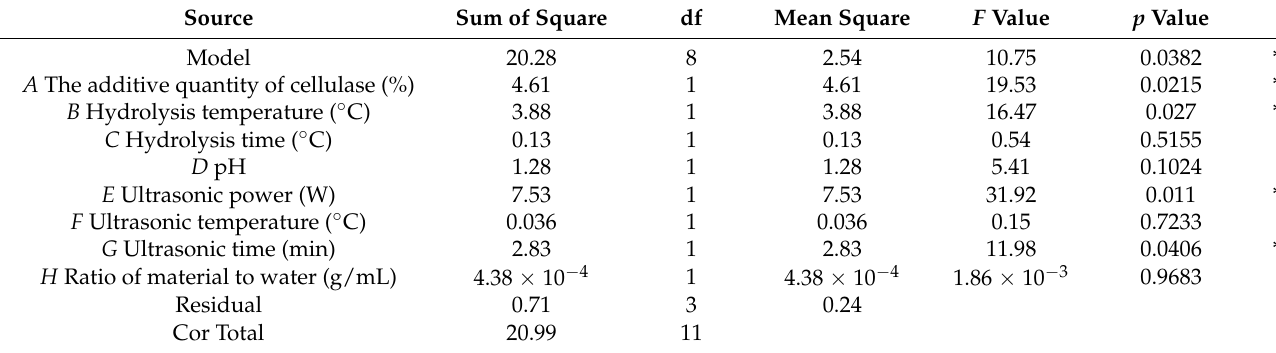
Table 2. Plackett–Burman test